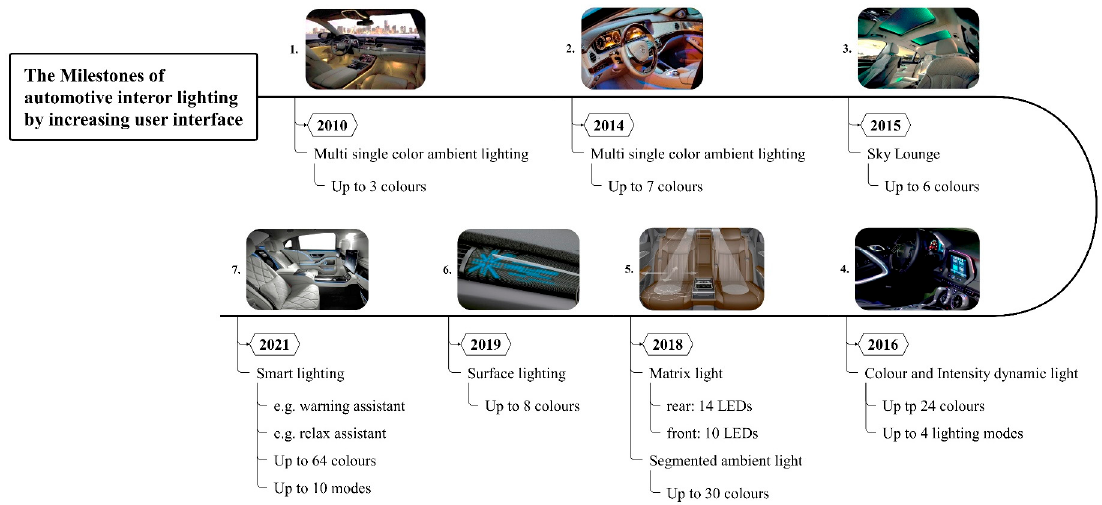
Figure 1. Chronology of in-vehicle lighting system [3–5] .